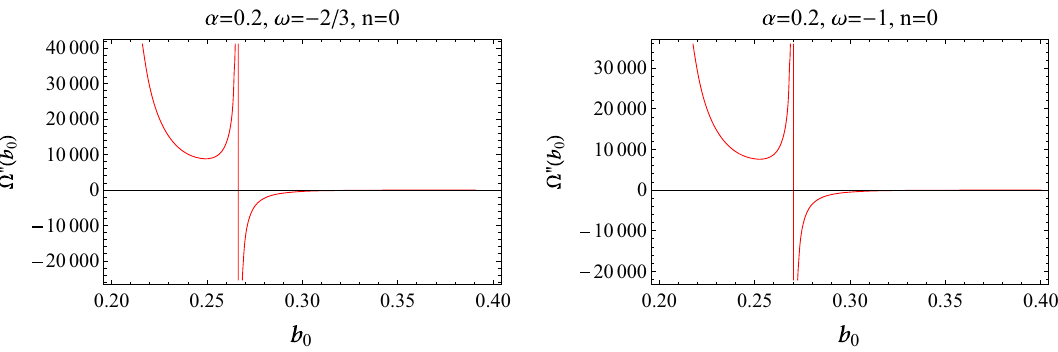
Fig. 6 Stable and unstable behavior of thin-shell gravastars with phantomlike EoS ( n = 0) for different values of ω . It shows stable behavior initially then expresses unstable configuration for every choice of ω